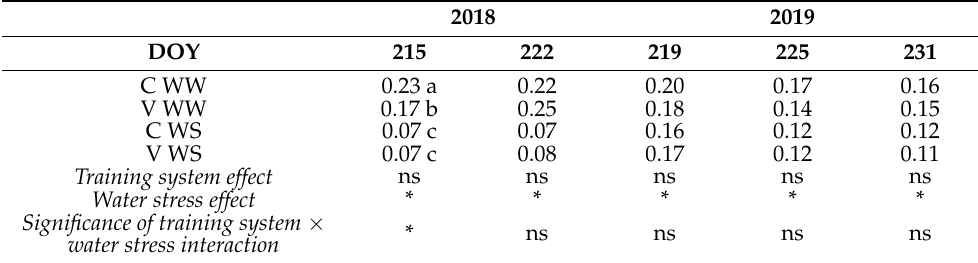
Table 4. Leaf stomatal conductance (gs, mol m − 2 s − 1 ) during the 2018 and 2019 seasons. Values represent means of 4 replicates: C WW= well-watered vertical shoot-positioned canopy, V WW = well-watered V-shaped open canopy, C WS = vertical shoot-positioned canopy with water restriction, V WS = V-shaped open canopy with water restriction. Significant differences are indicated: *, p < 0.05; ns, not significant. Mean values were separated within each column with different letters using the Tukey test.